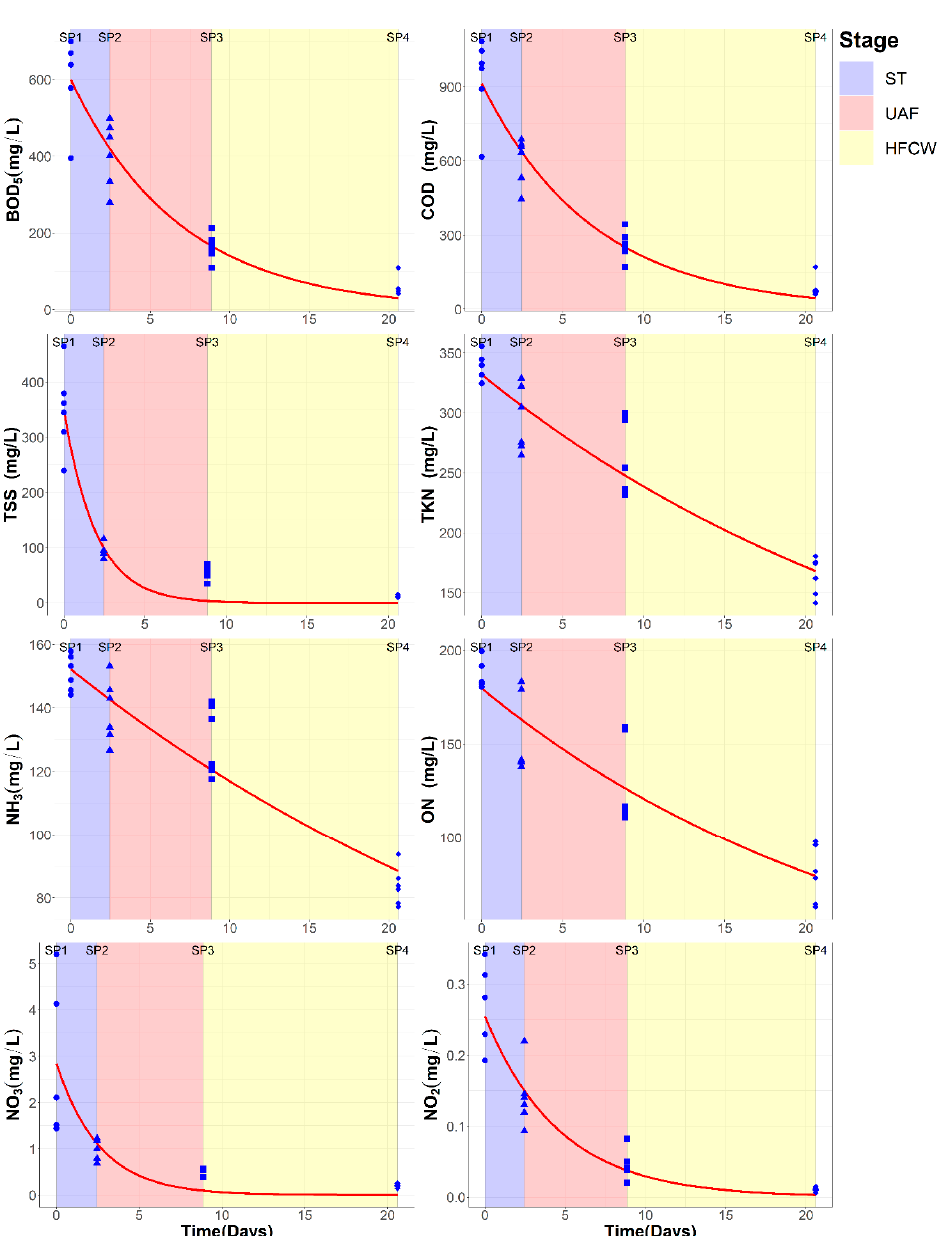
Figure 3. Experimental data and first-order kinetic model adjustment (red line).